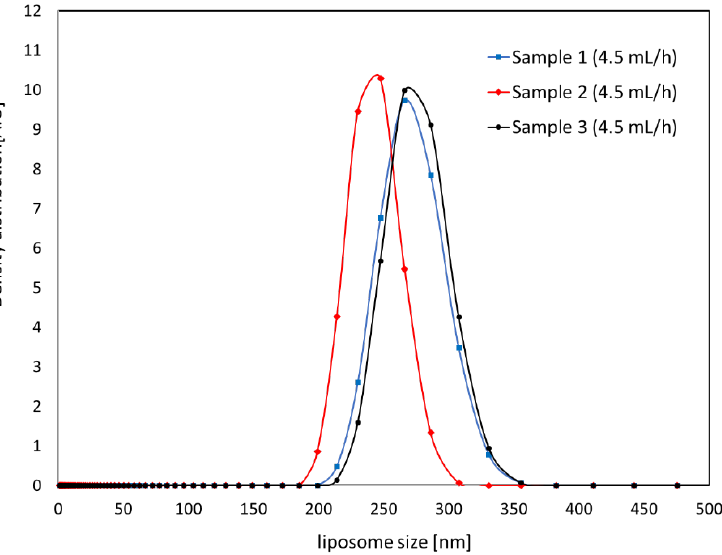
Figure 14. Liposome size distribution measured for three samples synthesized at 4.5 mL/h of lipid solution and 30 mL/h of saline. Table 1. Average and standard deviation for liposomes.